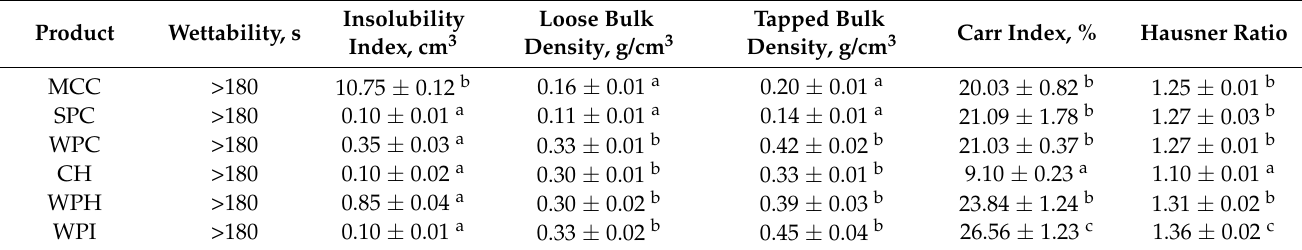
Table 2. Properties of high-protein milk